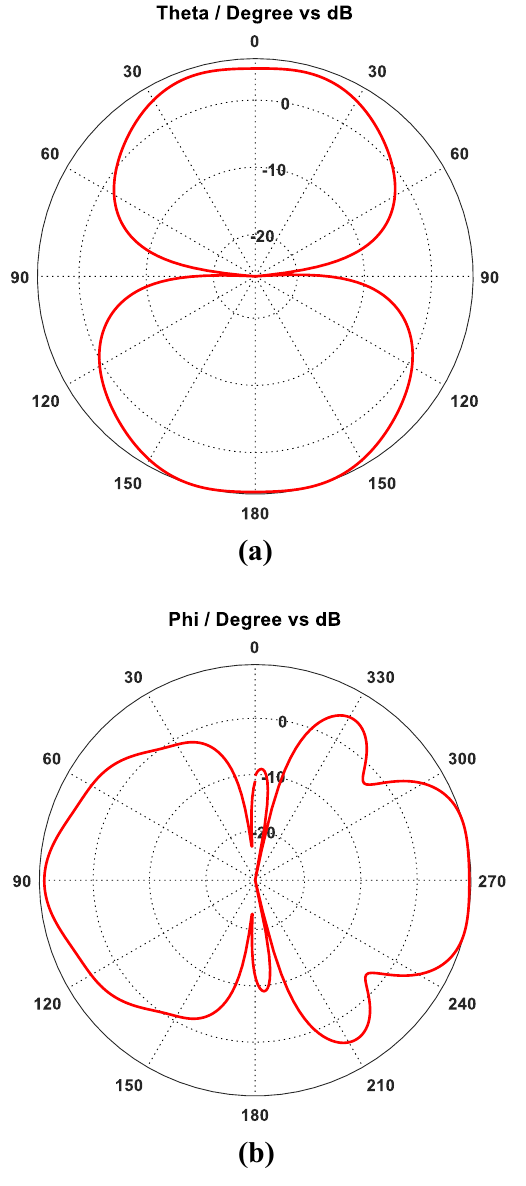
Fig. 13 Polar plot of L-shaped graphene nano patch a E plane b H plane